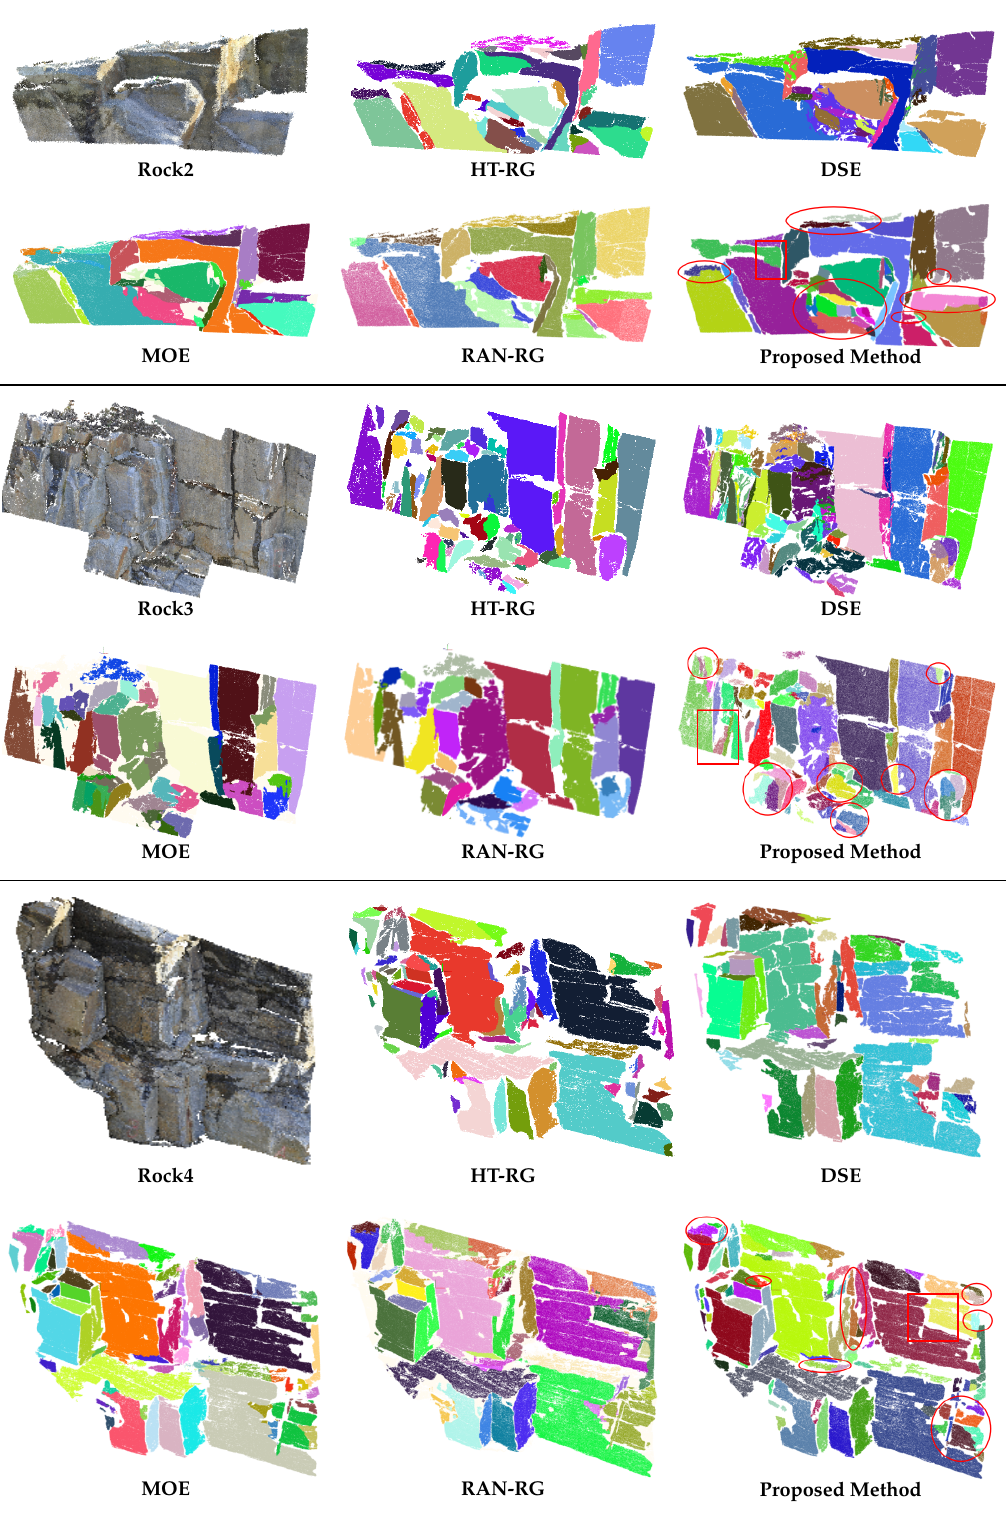
Figure 10. Detection Results of Rock2, Rock3 and